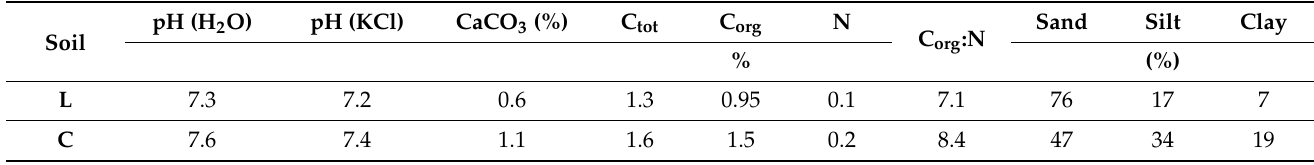
Table 4. Basic physiochemical properties of L and C